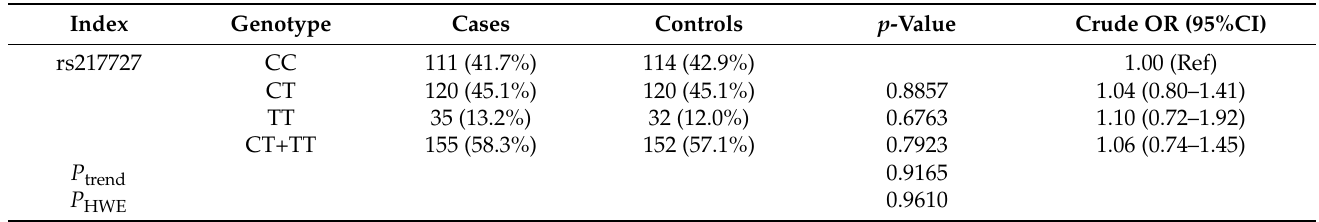
Table 4. Distributions of H19 rs217727 genotypes between childhood leukemia and control groups.